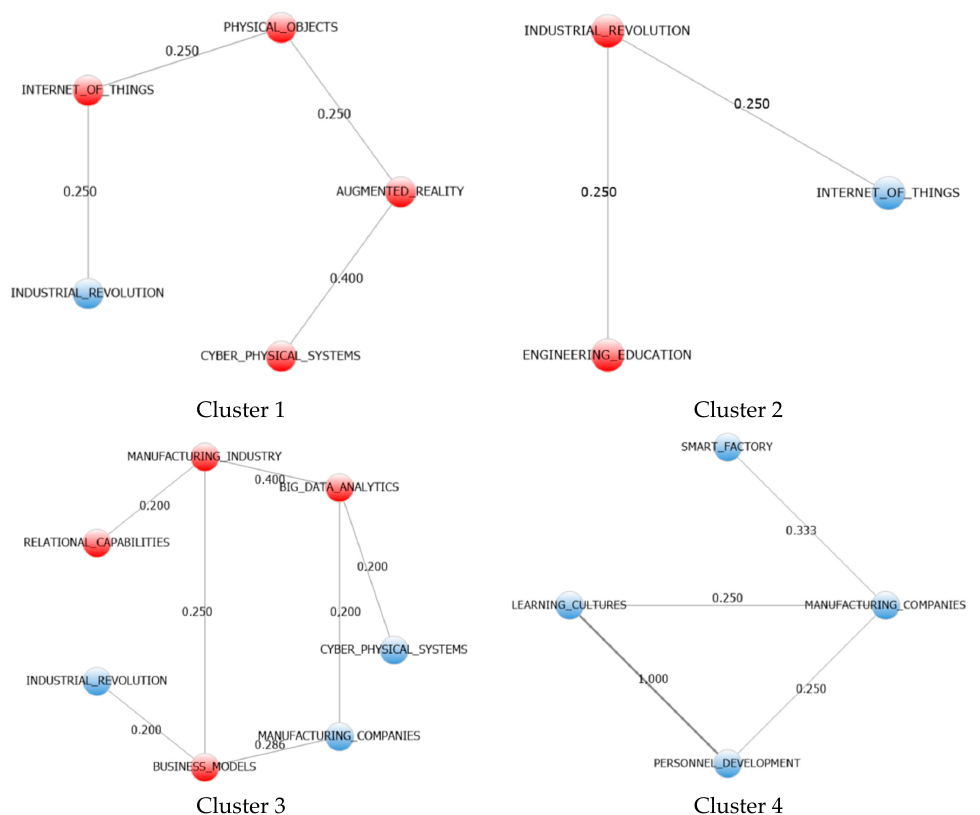
Figure 4. Proximity plots of phrases in